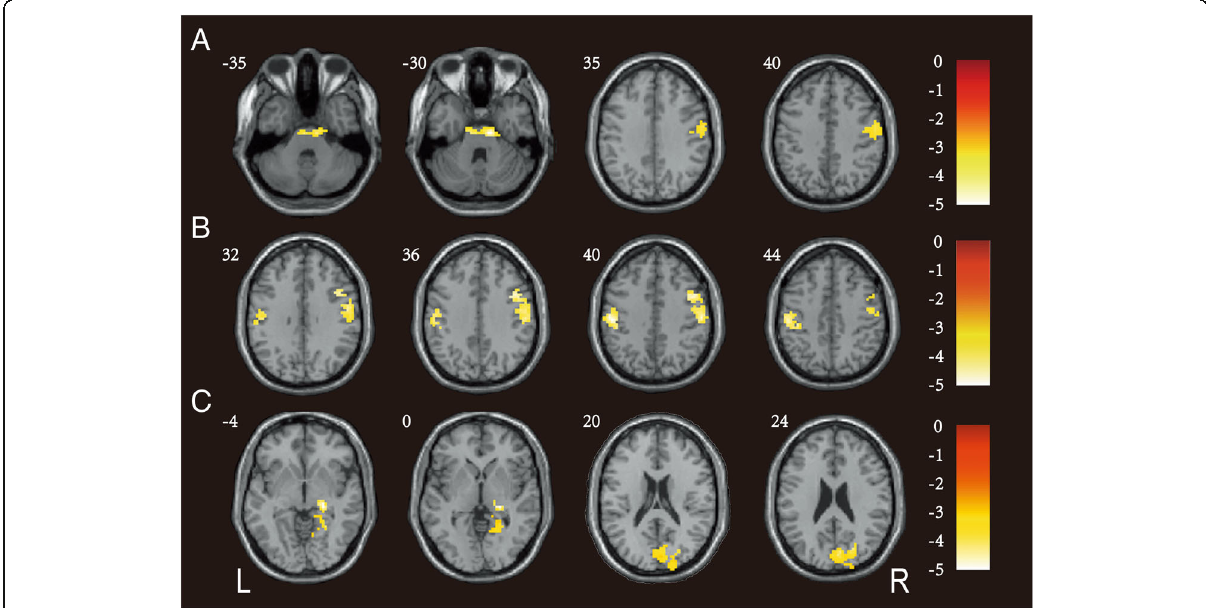
Fig. 2 FC of brain areas with abnormal ALFF values was compared with that in other brain areas between the CADASIL and control groups. a The CADASIL group had weaker FC between the left SFG and right precentral gyrus and between the left SFG and bilateral pons. b Weaker FC between the right SFG and right precentral gyrus and between the right SFG and left postcentral gyrus was observed in the CADASIL group compared to the control group. c The patients with CADASIL displayed significantly weaker FC between the right Pcu/CU and right CU and between the right Pcu/CU and right PHG. The color-coded scale was referred to the t-values. FC: functional connectivity; ALFF: amplitude of low-frequency fluctuation; CADASIL: cerebral autosomal dominant arteriopathy with subcortical infarcts and leukoencephalopathy; SFG: superior frontal gyrus; Pcu/CU: precuneus and cuneus; CU: cuneus; PHG: parahippocampal